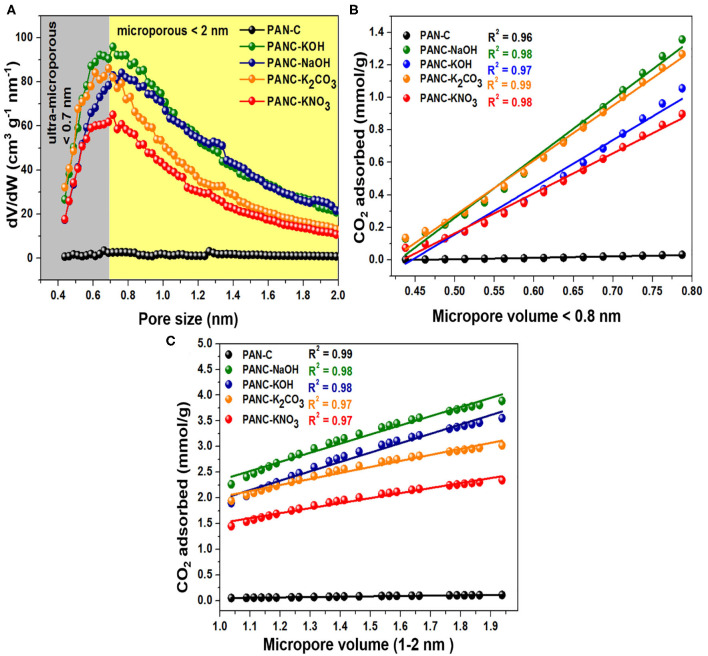
(A) Micropores size distributions carried out by HK calculations through CO2 adsorption data, correlation among CO2 uptakes and the fraction of micropore volume (B) < 0.8 nm and (C) between 1 and 2 nm, at 273 K and 1 bar.